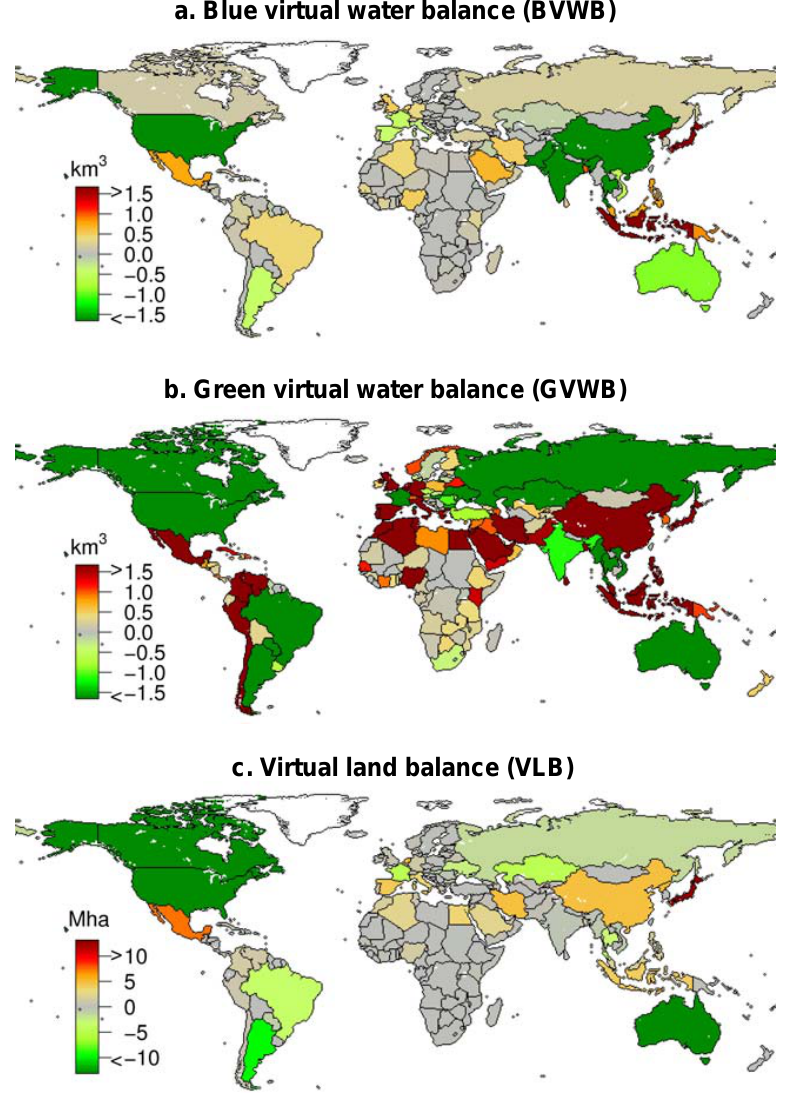
Fig. 3. Countries’ net virtual water and land balances for the 11 CFTs considered. Negative (positive) values indicate a net export (import) of virtual water or land. All values represent the means of the period